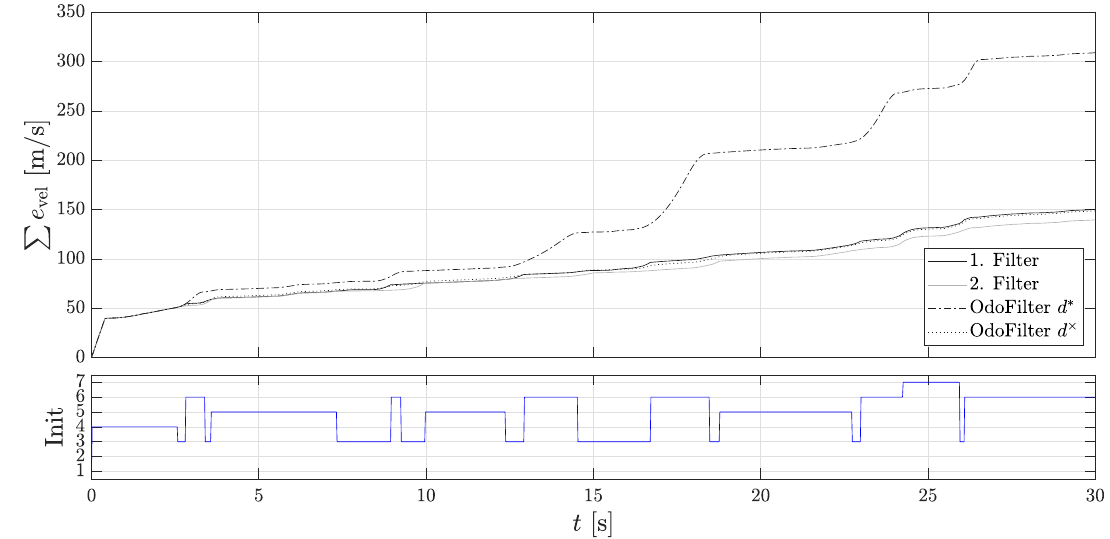
Figure 10. Accumulated velocity errors of the Dual-Localization filter on the slope hill. ( Top ): The accumulated velocity errors of the 1st and the 2nd localization filter, of the localization filter using the fused estimated velocity of the new methods, and of the velocity of the localization filter using the rolling direction of the DWPC signal; ( Bottom ): Initialization states.